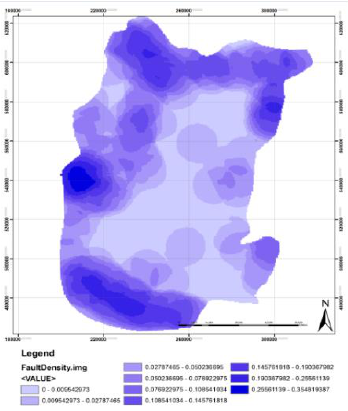
Figure 6. Fault classification map